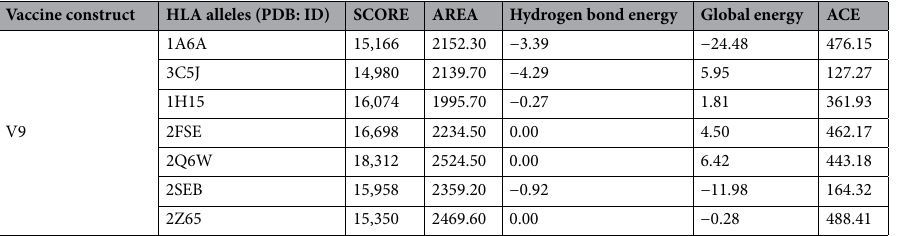
Vaccine construct HLA alleles (PDB: ID) SCORE